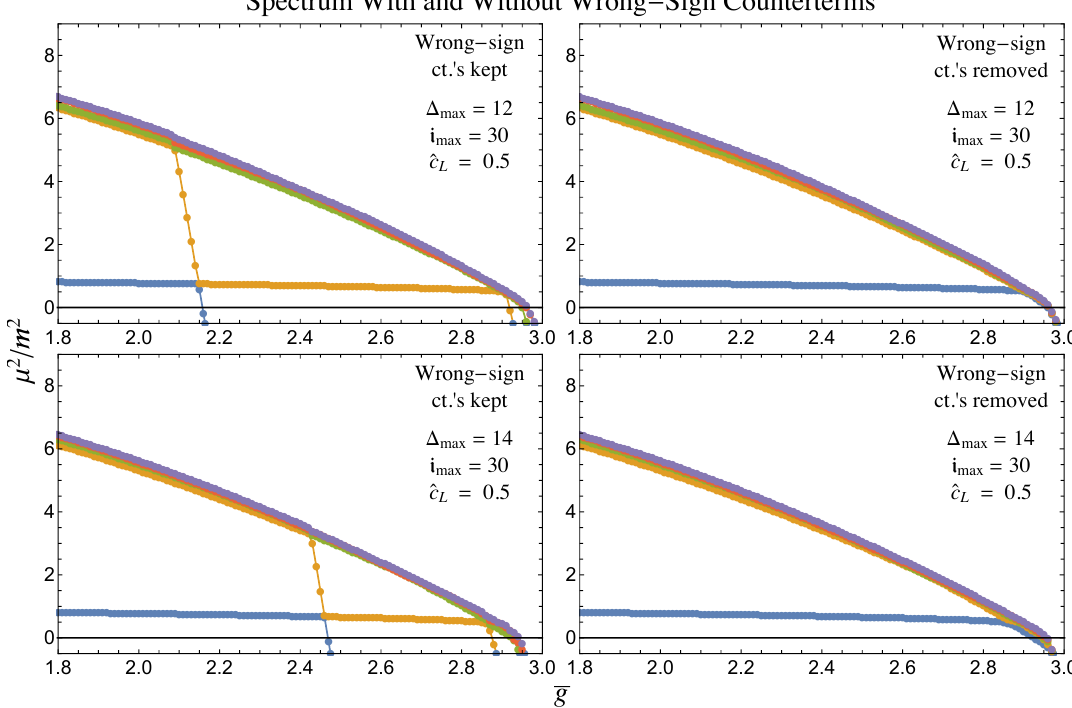
Figure 20 . The first five eigenvalues in the Z 2 -odd sector, where the wrong-sign entries in the counterterm have not been removed (left side) and where they have been removed (right side). Note the relatively small truncation cutoff ∆ = 12 chosen in the top row of plots. Increasing to max ∆ = 14 (bottom row), the crashing behavior moves to higher values of ¯ g max